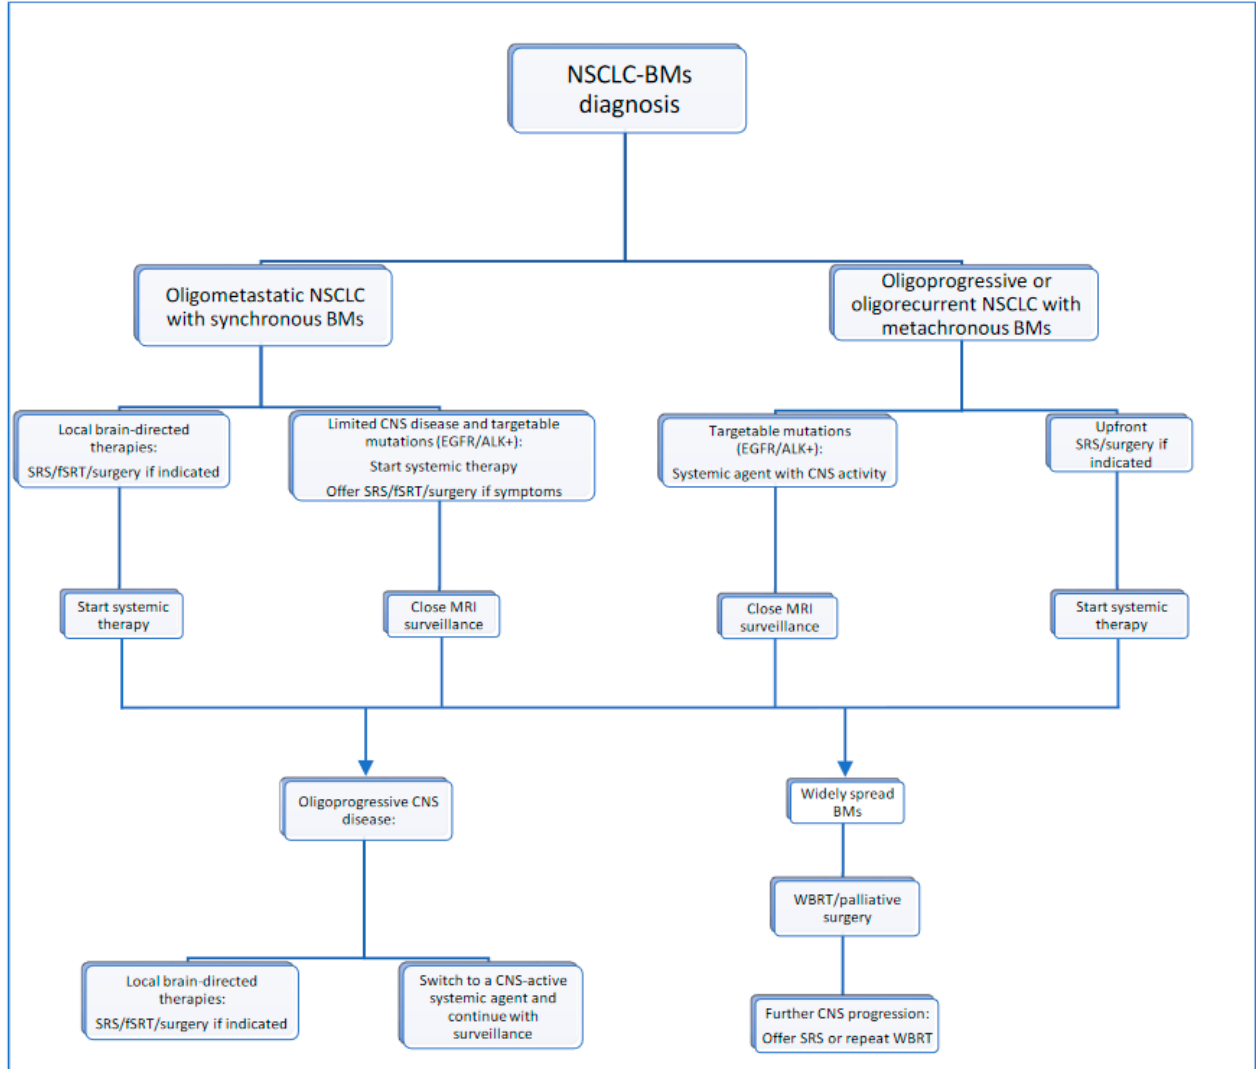
Figure 1. Proposed treatment algorithm for NSCLC-BM.